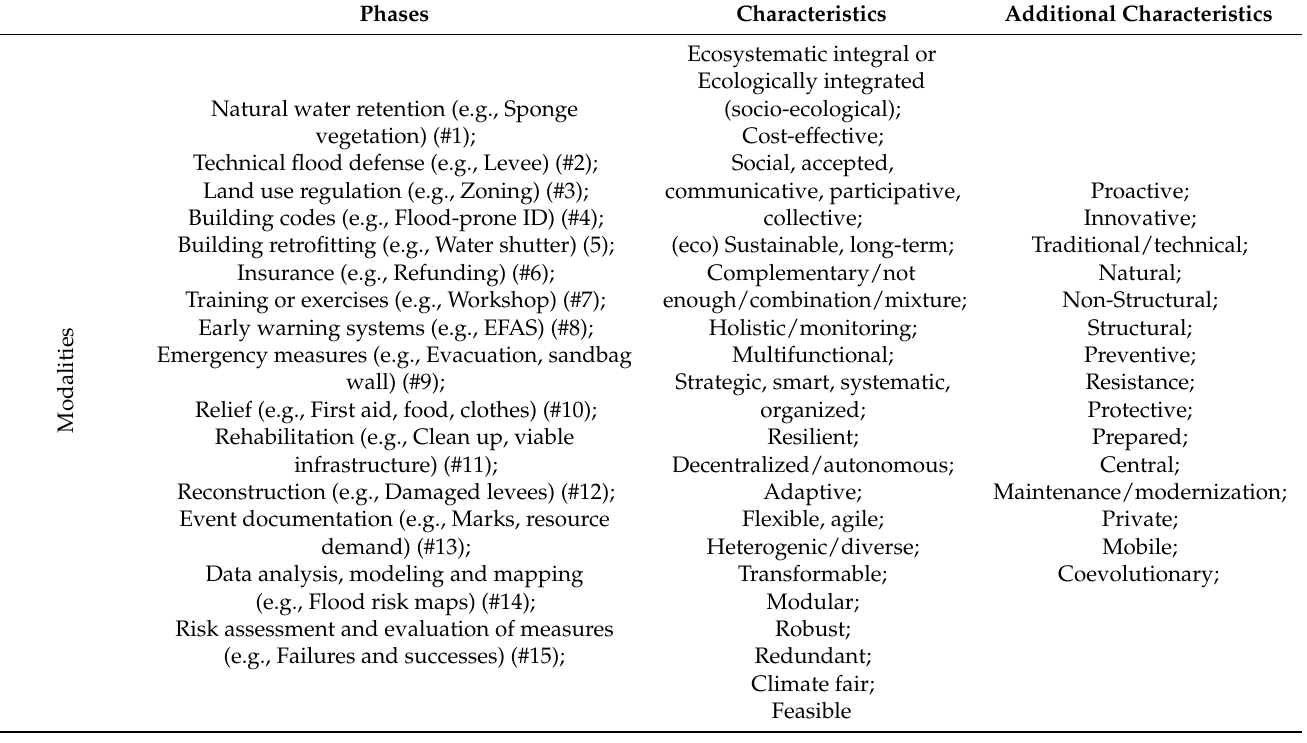
Table 2. Modalities used for the assessment on prioritized FM phases inspired by [43] (# plus a number indicating its position in FM cycle) and assessed FM characteristics in the expert survey and analyzed literature. “Phases” were the same in both analyses while the literature analysis assessed “characteristics” and “additional characteristics” and, in the survey only,